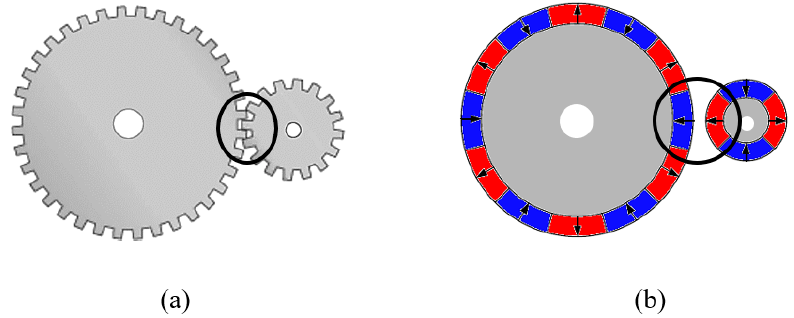
Figure 6. Analog gears: ( a ) Mechanical spur gear; ( b ) Magnetic spur gear.